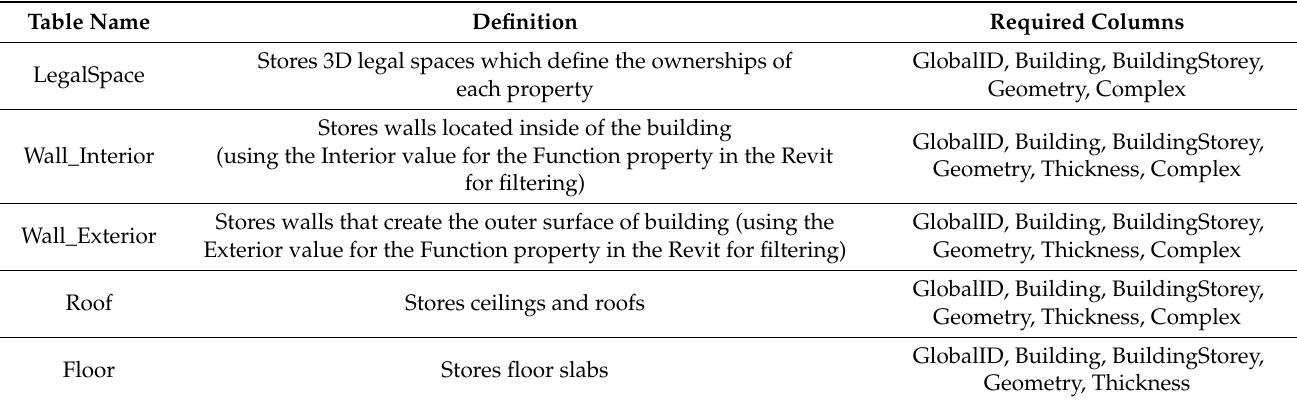
Table 1. The required tables for performing boundary identification analysis in the database. Table